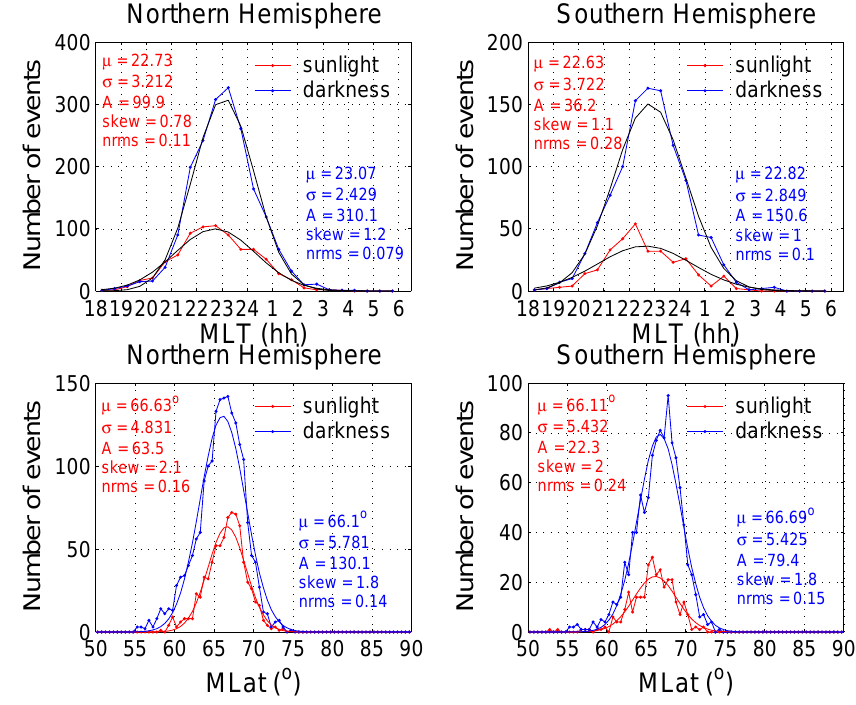
Fig. 5. Same as Fig. 3, but for solar zenith angle, SZA > 100 ◦ (darkness) and SZA < 100 ◦